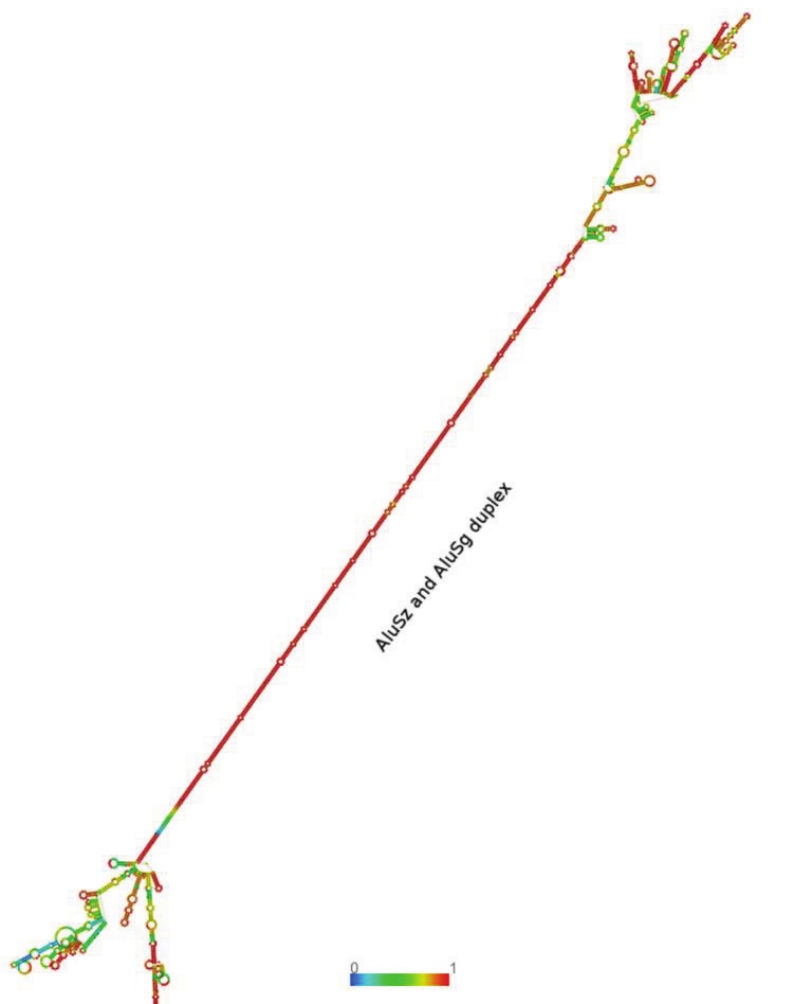
Figure 3. IRAlus within the 3'UTR of FUT2 . The dsRNA duplex formed within the 3'UTR of FUT2 (transcript id ENST00000425340) by intermolecular base-pairing between sense AluSz (311 nt) and antisense AluSg (307 nt) elements. The secondary structure was predicted by RNAfold. The color scale represents base-paring probability with values ranging from 0 to 1 and red color indicating strong base-pair